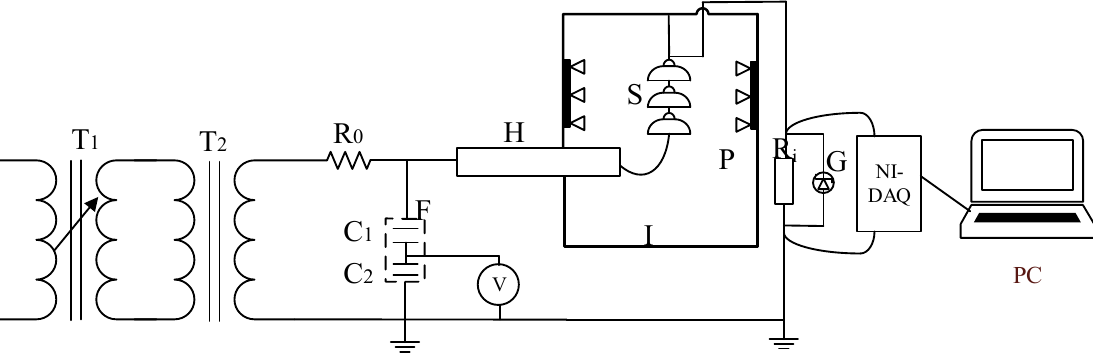
Figure 5. Schematic diagram of AC test circuit. Each part is introduced as follows. T 1 : Voltage